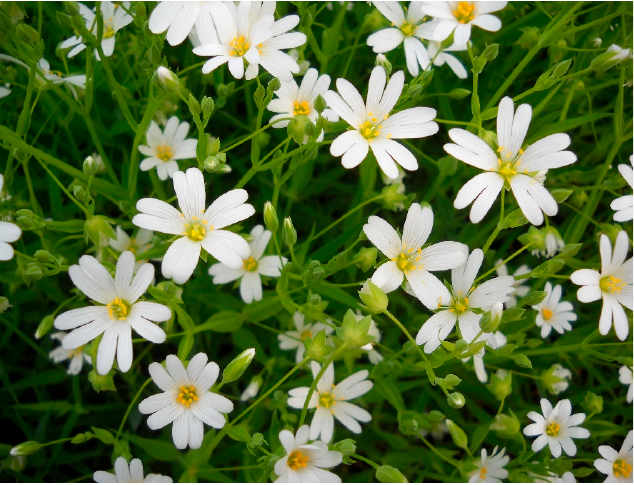
Figure 1. Rabelera holostea (L.) M. T. Sharples & E. A. Tripp (Caryophyllaceae) aerial parts with flowers (Photo by: J. S. Katani ć Stankovi ć , April 2015).